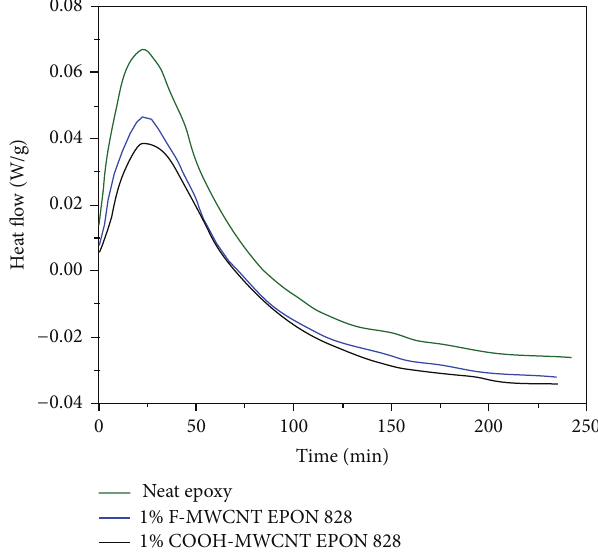
Figure 5: Isothermal DSC thermograms of neat EPON828, 1wt% F-MWCNTs/epoxy and COOH-MWCNT/epoxy, nanocomposites at 120 ∘ C. After